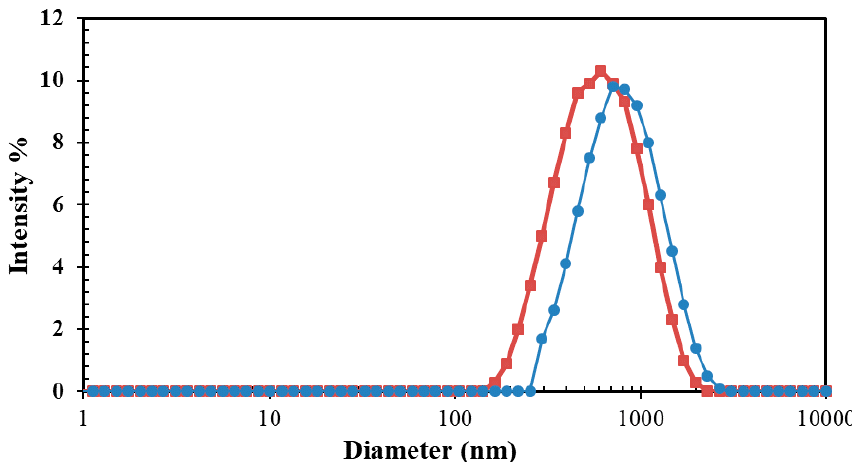
Figure 5. Particle size distribution of 0.1 wt% and 1wt% nanoclay dispersions using DLS: 0.1 wt%, blue circle; 1 wt%, red square.